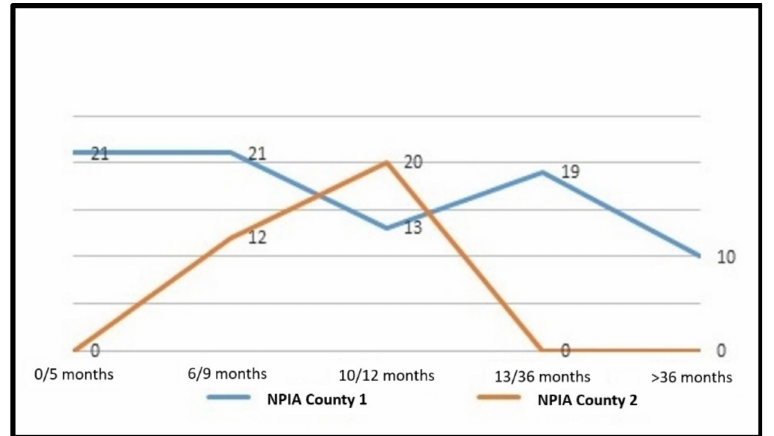
Figure 4. Children placed under the care of neuropsychiatric infantile and adolescence (NPIA) in the examined provinces.